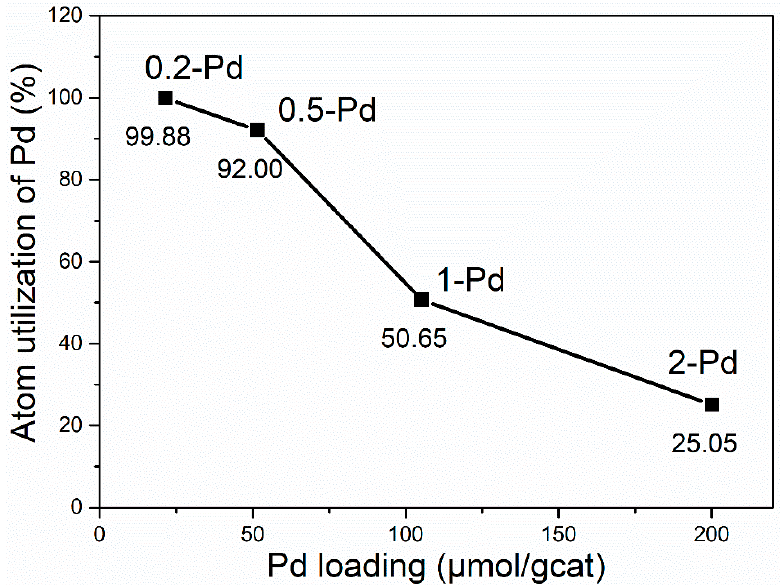
Figure 6. Tendency between Pd loading and the atom utilization of Pd.